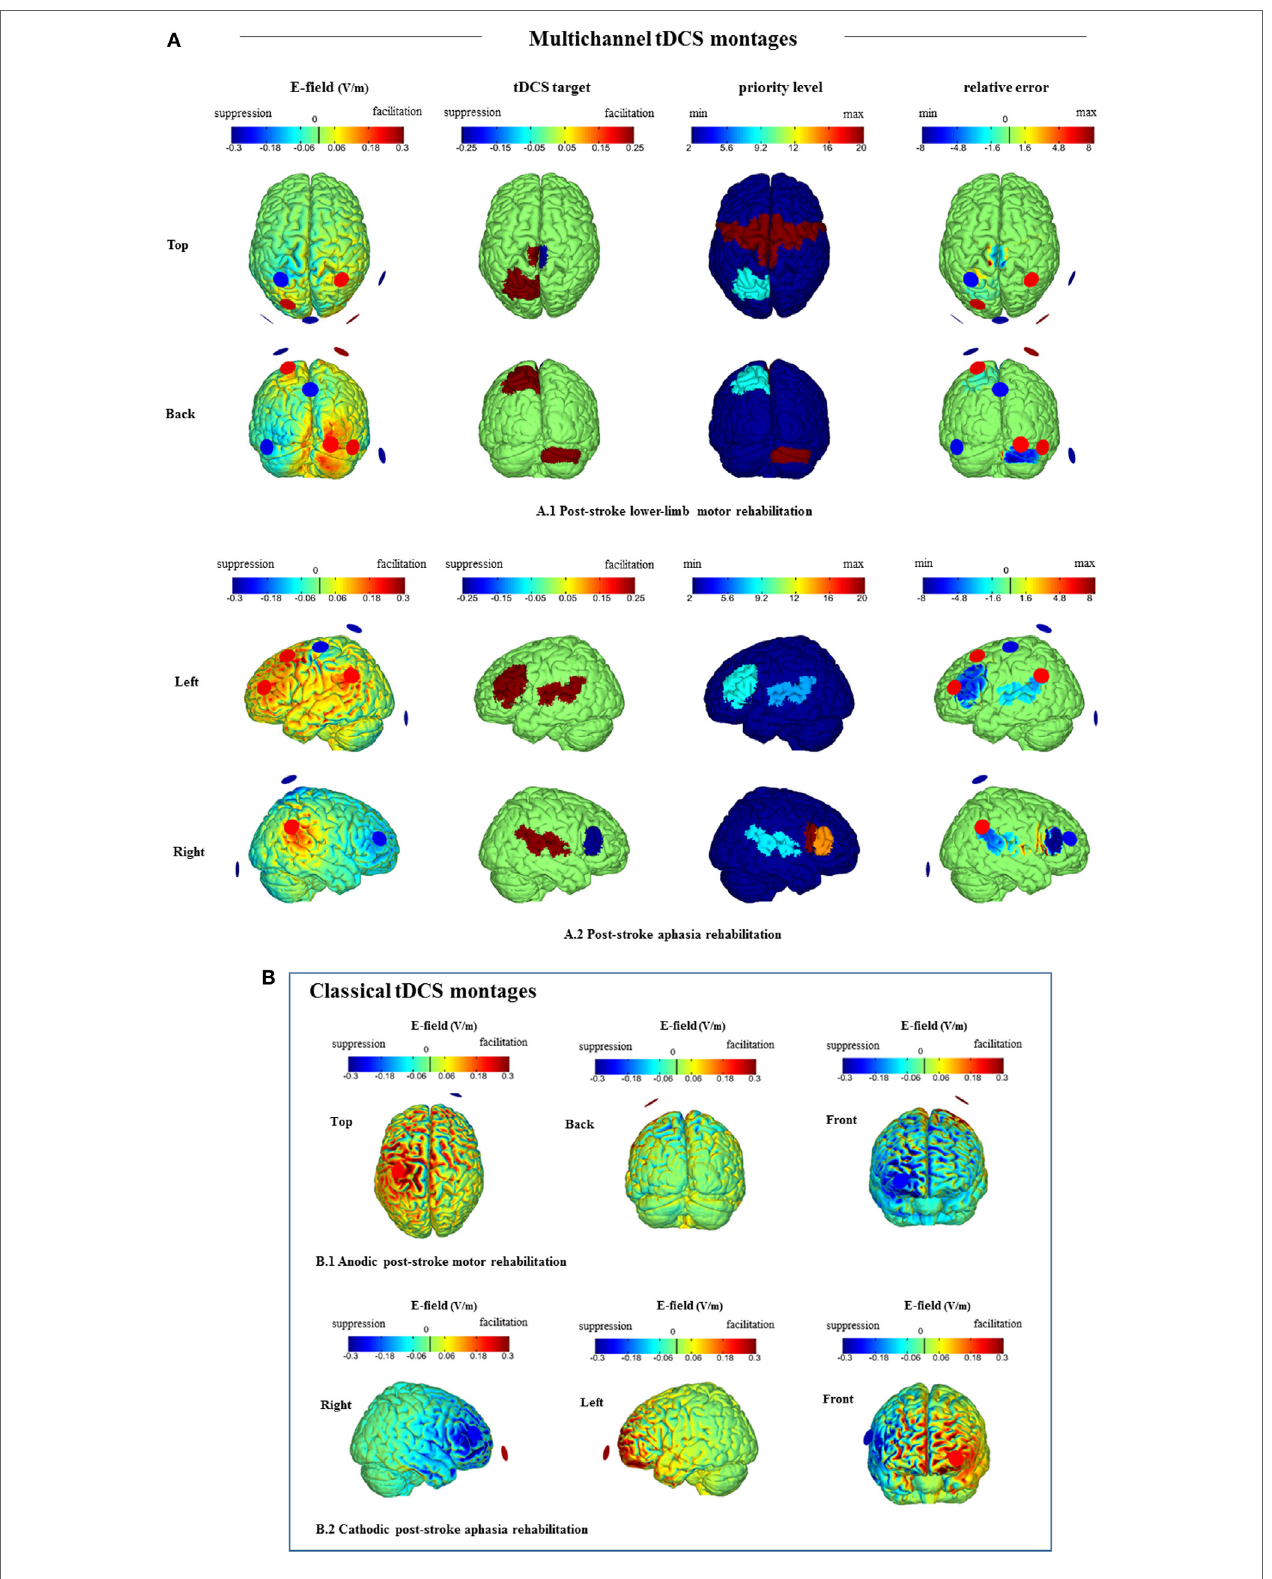
FiGUre 1 | Stimweaver simulations for (A) guided multichannel tDcs montages vs. (B) classical tDcs montages .